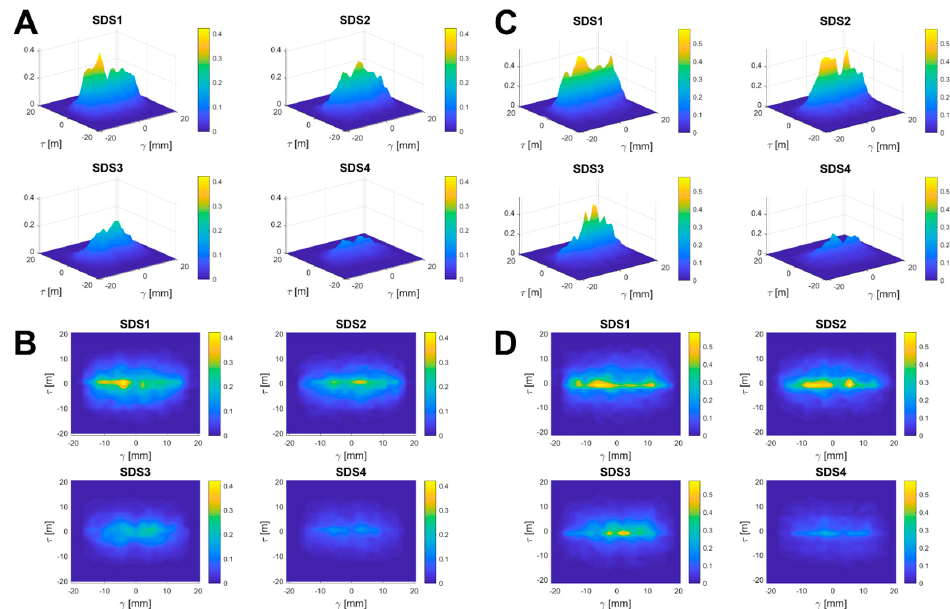
Figure 5. Graphical representation of SDS plots regarding two SSAs at increasing quartiles of corti- cal depth. ( A , B ) Lateral and top views of SDS plots regarding the first subject. ( C , D ) Lateral and top views of SDS plots regarding the second subject.